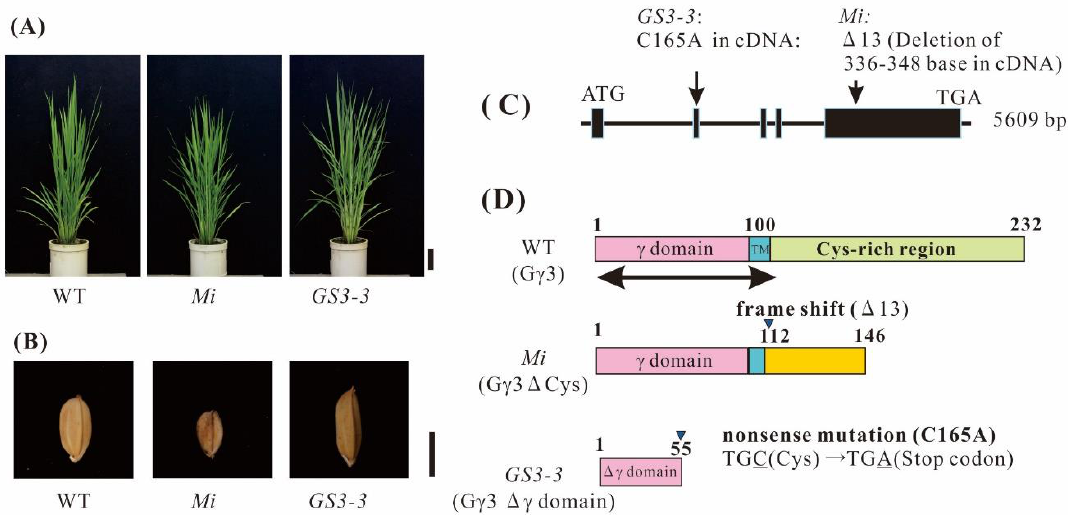
Figure 1. Morphology of rice heterotrimeric G protein γ 3 gene ( RGG3/GS3/Mi/OsGGC1 ) mutants, and genome and protein structure of RGG3/GS3/Mi/OsGGC1 . ( A ) Gross morphology of the wild-type (WT) (Taichung 65), Mi and GS3-3 ; Bar = 10 cm. ( B ) Seed morphologies of the plants in ( A ); Bar = 5 mm. ( C ) Genome structure of RGG3/GS3/Mi/OsGGC1 and positions of mutations in RGG3/GS3/Mi/OsGGC1 mutants, Mi and GS3-3 . The 13-base deletion (336–348th base in full-length cDNA) and one base substitution (C165A in full-length cDNA) had occurred in Mi and GS3-3 , respectively. In GS3-3 , a codon, TGC (cysteine) changed to TGA (stop codon). ( D ) Protein structure of the product of RGG3/GS3/Mi/OsGGC1 in the WT (G γ 3), Mi (G γ 3 ∆ Cys), and GS3-3 (G γ 3 ∆ γ domain). The canonical γ domain region is shown as γ domain (pink bar). The putative transmembrane domain is indicated as TM (blue bar). The region with cysteine abundance is labeled as cysteine-rich region (green bar). The newly produced amino acid sequence by the frame shift resulting from of 13-base deletion is indicated with a yellow bar. An arrow under the WT G γ 3, which covers 120 amino acid residues from N-terminal, is the region used for recombinant proteins, such as the thioredoxin (Trx)-tagged G γ 3 domain protein (Trx-G γ 3 domain protein), used as an antigen, and the glutathione S transferase (GST)-tagged G γ 3 domain protein (GST-G γ 3 domain protein), used for affinity purification of the antibody.